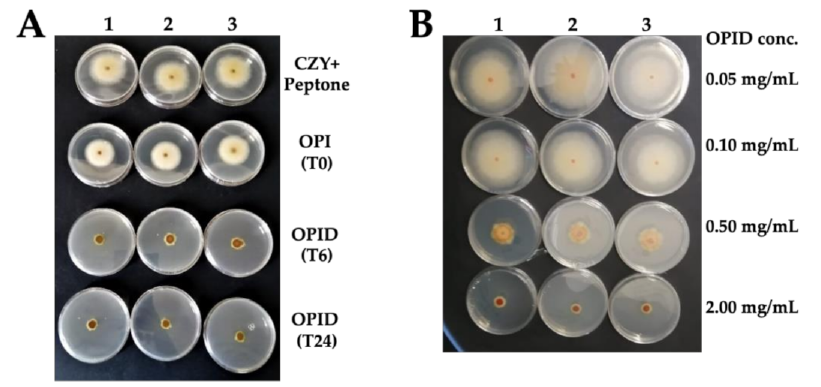
Figure 6. Antimicrobial activity of OPI and OPIDs on Fusarium graminearum . ( A ) Samples were tested at a concentration of 0.5 mg/mL. ( B ) The OPID (T24) sample was tested at different concentrations. F. graminearum grown in CZY medium added with equivalent peptone concentration was set as reference. OPI (T0) represents undigested okara proteins, while OPID (T6) represents 6 h digested proteins and OPID (T24) represents 24 h digested okara proteins. Three experimental replicas (1, 2, and 3) are